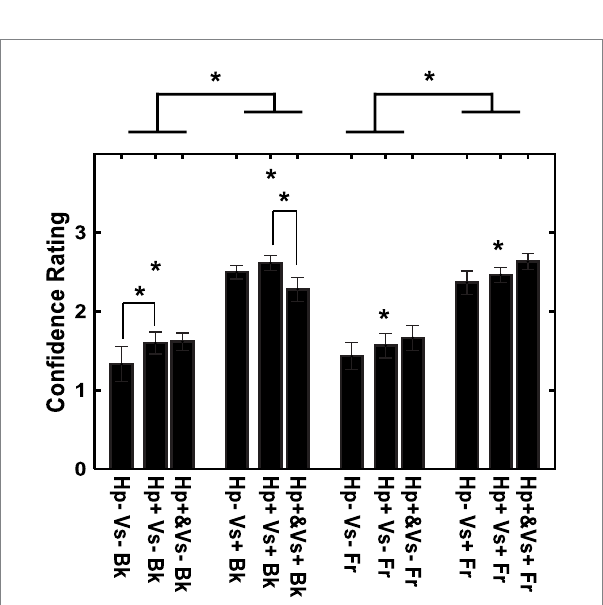
FIGURE 5 Confidence in depth perception for individual conditions. Vs +: visual cue present with binocular stereopsis. Vs − : visual cue absent with monocular presentation. Hp+&: haptic cue with visual presentation. Hp+: haptic cue subsequently to visual presentation. Hp − : no haptic cue. Fr: virtual ribbon in front of the word. Bk: virtual ribbon as a hollow in the word in the background. *: difference statistically